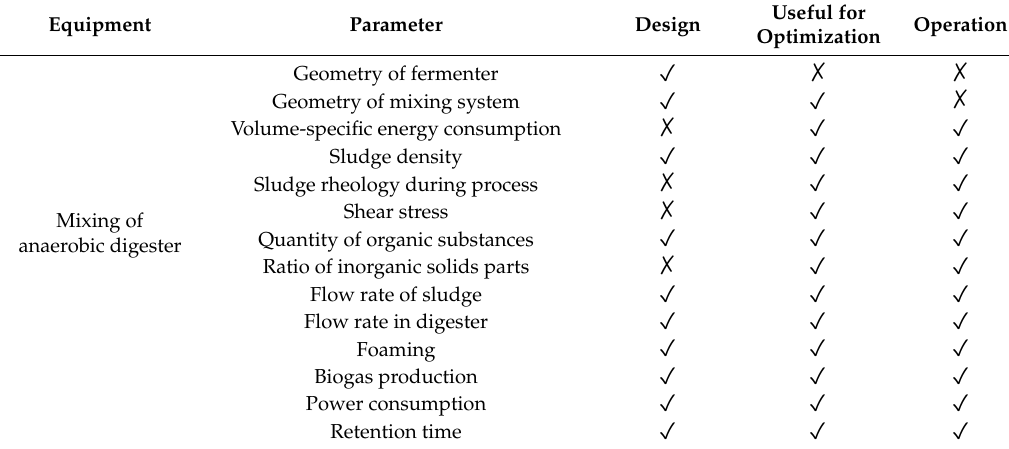
Table 5. Parameters of the anaerobic digester